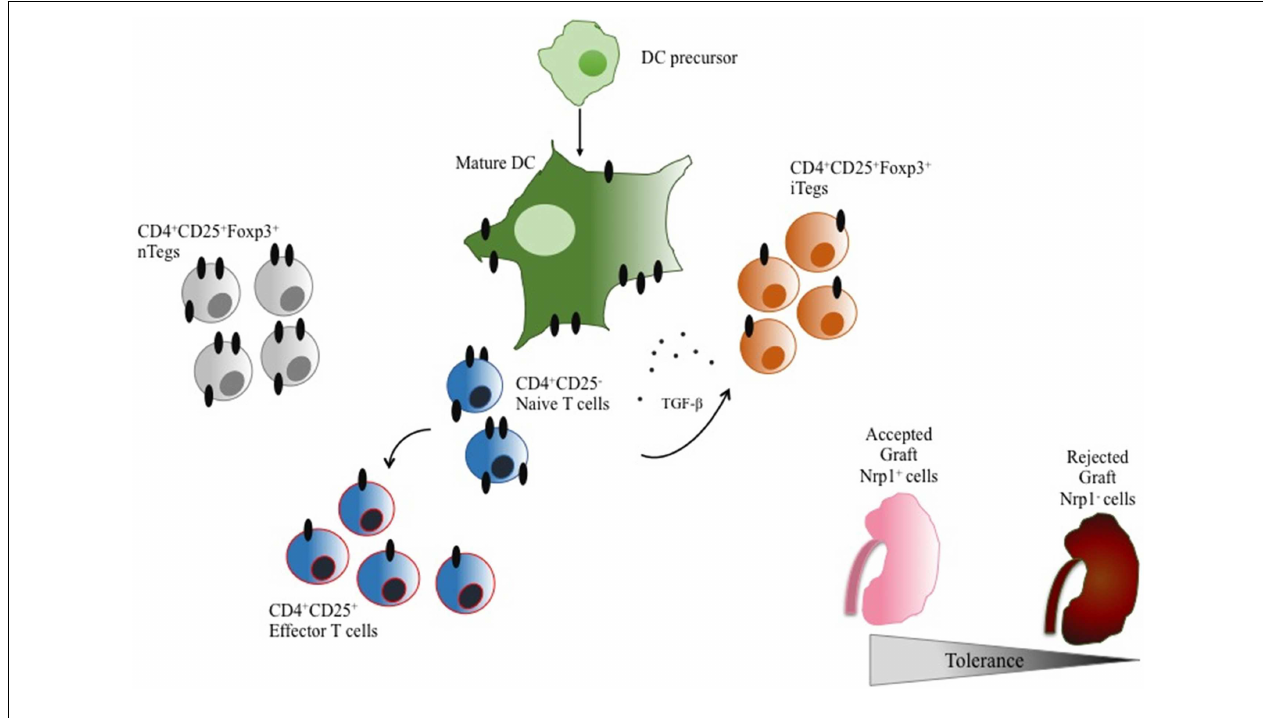
FIGURE 3 | Neuropilin-1 expression in DCs and CD4 + T cells . DC precursors express very low levels of Nrp1. In contrast, mature DCs express high levels of Nrp1. Naïve CD4 + CD25 − T cells constitutively express Nrp1, which is downregulated uponT-cell activation. Interestingly, nTregs